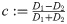
Comparison of system dynamics.Evolution of the mean correctness c:=D1-D2D1+D2 and the variance σ for the full model (black/gray lines; subscript full) and the reduced one-dimensional one (red lines; subscript 1D). Opaque lines show the evolution of cdet, i.e. for the corresponding deterministic system where σ = 0. (a) Poincaré section of the system for ωt = 2πn with n∈N, i.e. at the beginning of each forcing cycle; (b) complete time series for t/(2π) < 5, i.e. the first 50 forcing cycles.